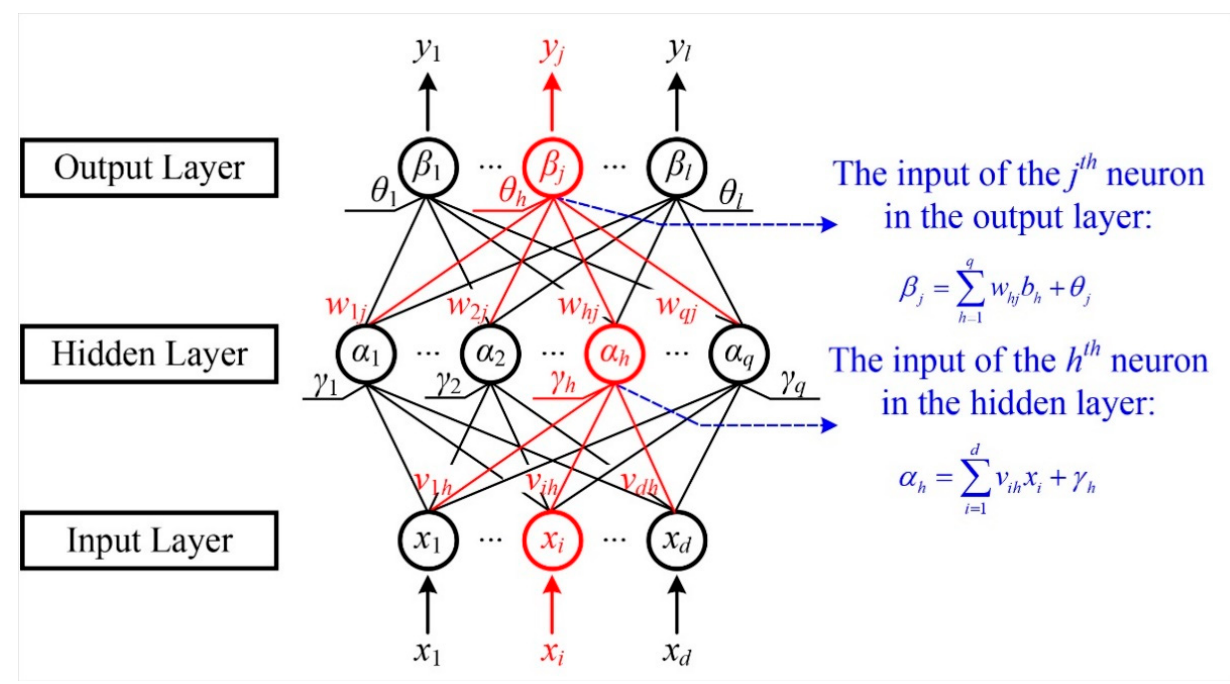
Figure 5. The forward propagation schematic diagram of the three-layer multilayer perceptron model .